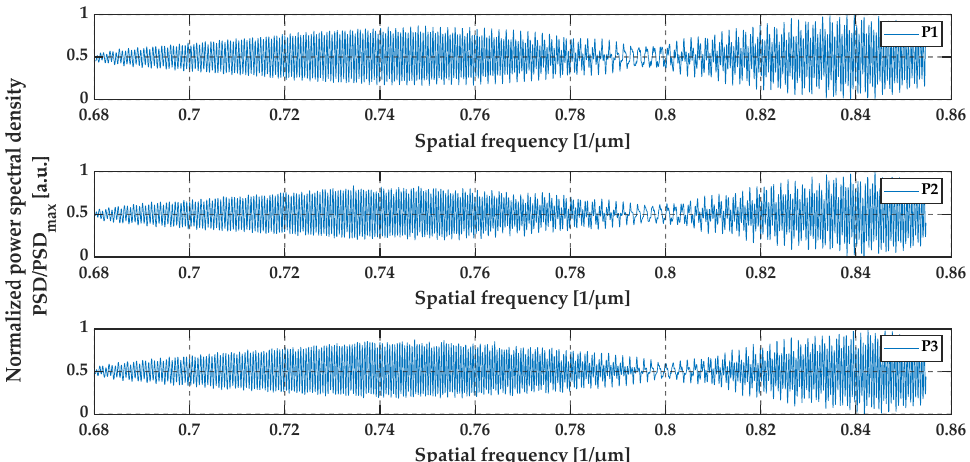
Figure 15. The preprocessed data at positions P1, P2, and P3.